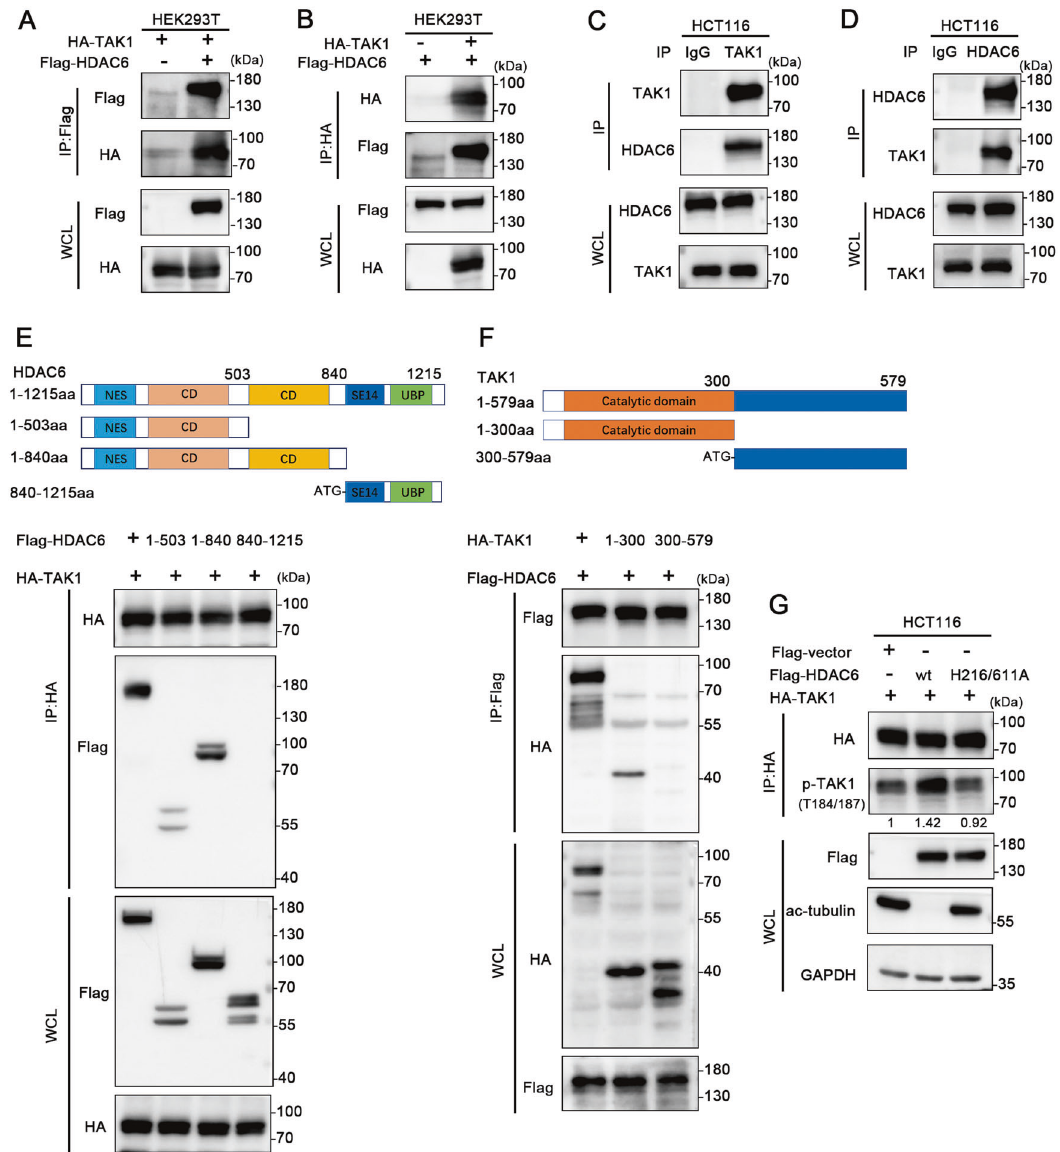
Fig. 5 HDAC6 interacts with TAK1. A , B Interaction between HDAC6 and TAK1 was assessed by co-expressing the proteins in HEK293T cells. C , D Analysis of the endogenous interaction between TAK1 and HDAC6 in HCT116 cells by immunoprecipitation. E , F Binding domains between HDAC6 and TAK1 were determined using constructs expressing full-length and truncated HDAC6 and TAK1. G . Phosphorylation of exogenously expressed HA-TAK1 evaluated after transfection with the empty vector, Flag-HDAC6-WT or Flag-HDAC6-H216/611A. Whole-cell lysates were immunoprecipitated with an anti-HA antibody, and the precipitated proteins were probed with a p-TAK1(T184/187) antibody. WCL is the abbreviation of whole-cell lysate. WT is the abbreviation of wild of an acetyl group on the T178 residue of TAK1 could change the cells and performed mass spectrometry assay. The mass spectro- spatial conformations of the T184 and T187 sites. Moreover, metric analysis suggested the acetylation site of TAK1 is T178 spatially, the three sites are relatively close, and the acetylation of (threonine 178), which locates in the kinase domain. Sequence T178 may affect the phosphorylation modi fi cation of the other alignments in different species revealed that that T178 is a highly two sites or their interaction with other molecules, further evolutionarily conserved residue, indicating the potentially critical affecting the phosphorylation and activation of TAK1 (Fig. 6B). role for T178 in the function of TAK1 (Fig. 6A). To further examine the associated effects, we mutated the T178 It has been reported that the phosphorylation of T178, T184, residue to a glutamine residue (to mimic acetylation) (T178Q) or and T187 residues of TAK1 is important for TAK1-mediated signal an arginine residue (to mimic deacetylation) (T178R). The results transduction [28, 37, 38]. Since the T184 and T187 residues are the showed that when the T178 residue of TAK1 was mutated, the key sites of TAK1 activation, these two sites were used to detect HDAC6-mediated regulation of TAK1 phosphorylation was abol- the phosphorylation of TAK1. We simulated the acetylation of ished, indicating that HDAC6 exerts its effect by acting on the TAK1 at T178 to preliminarily predict the corresponding effect on T178 residue. In addition, in the absence of HDAC6, the TAK1 activation. The AlphaFold model was performed to predict phosphorylation of the T178R mutant was increased, while that the protein structure of TAK1, and it was found that the addition